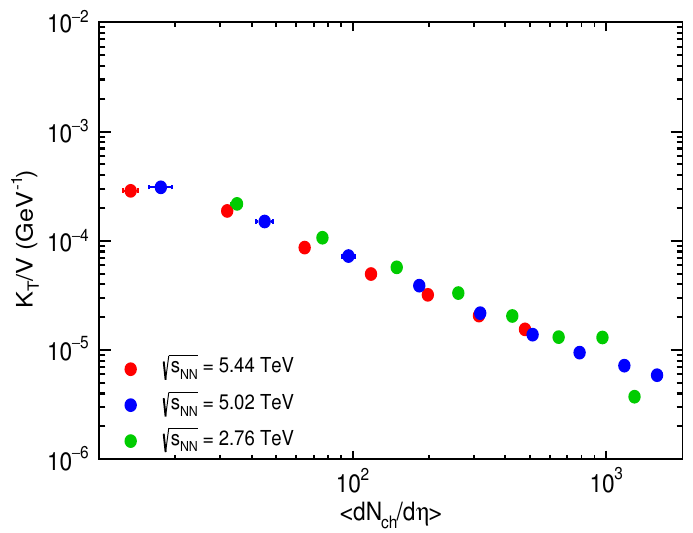
Figure 1. (Color online) Variation of isothermal compressibility over volume ( κ T / V ) with the average charged particle multiplicity ( √ s NN = 5.02 TeV and Xe − Xe collision at